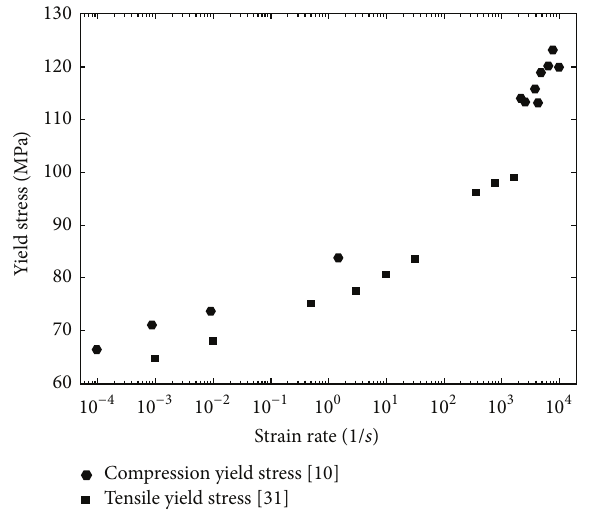
Figure 1: Experimental yield stress of